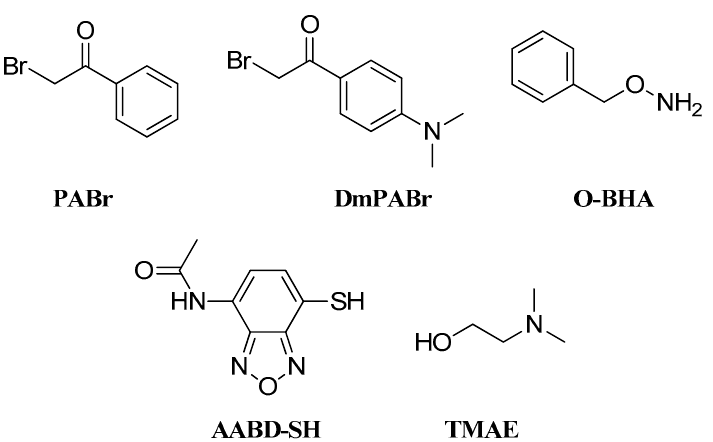
Figure 7. Bromides, hydroxylamines and other derivatization reagents for LC-HRMS analysis of FFAs.